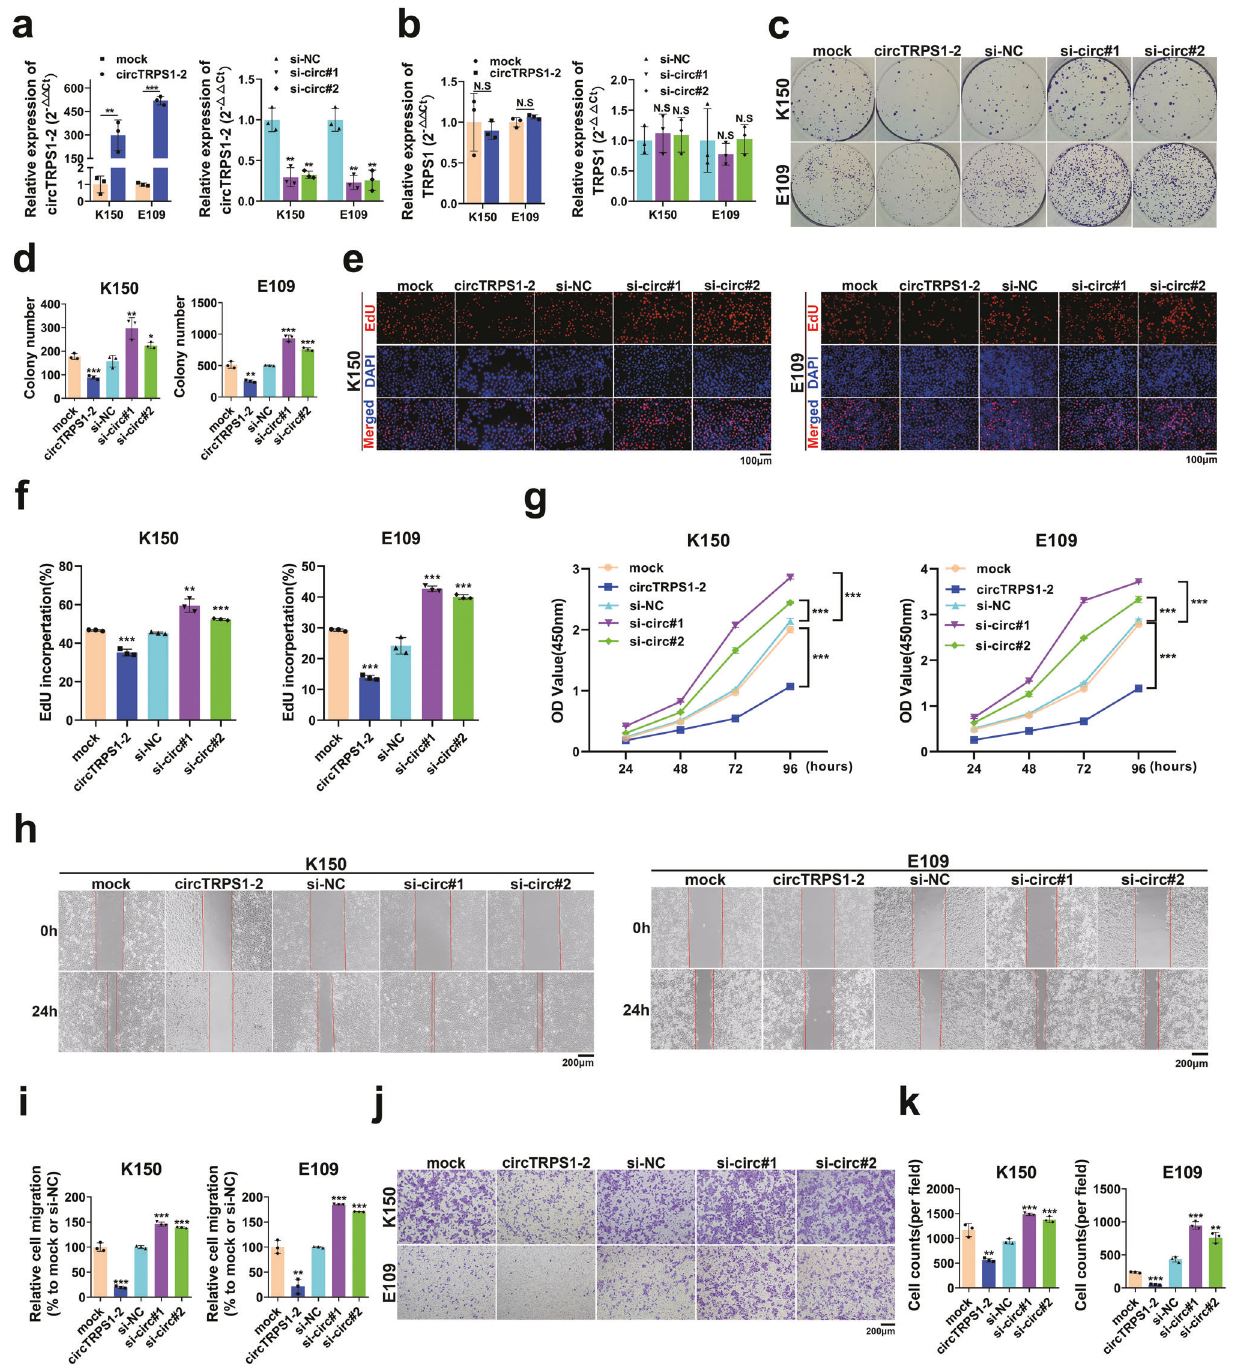
Fig. 4 Suppression of ESCC cell proliferation and migration by circTRPS1-2. a , b Con fi rmation of circTRPS1-2 overexpression or knockdown in ESCC cells, based on qRT – PCR. Expression of linear TRPS1 was not affected. β -actin was the reference gene. c , d Colony formation assay to assess the survival of ESCC cells over- or underexpressing circTRPS1-2. e , f EdU incorporation assay to evaluate the proliferation of ESCC cells. Magni fi cation, 200×. Scale bar, 100 µm. g Cell counting Kit-8 assay to evaluate cell viability. h , i Wound healing assay to evaluate the migration of ESCC cells. Magni fi cation, 100×. Scale bar, 200 µm. j , k Transwell assay to measure ESCC cell migration. Magni fi cation, 100×. Scale bar, 200 µm. Data are mean ± SD ( n = 3 independent experiments). * P < 0.05, ** P < 0.01, *** P < 0.001. circTRPS1-2, circTRPS1-2